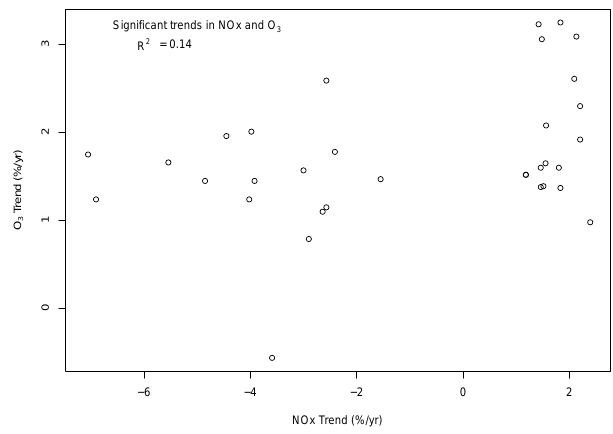
Fig. 10. Correlation of statistically significant annual trends in NO x (from the EMEP emission inventory, see text for details) and ob- served O 3 (40 sites)